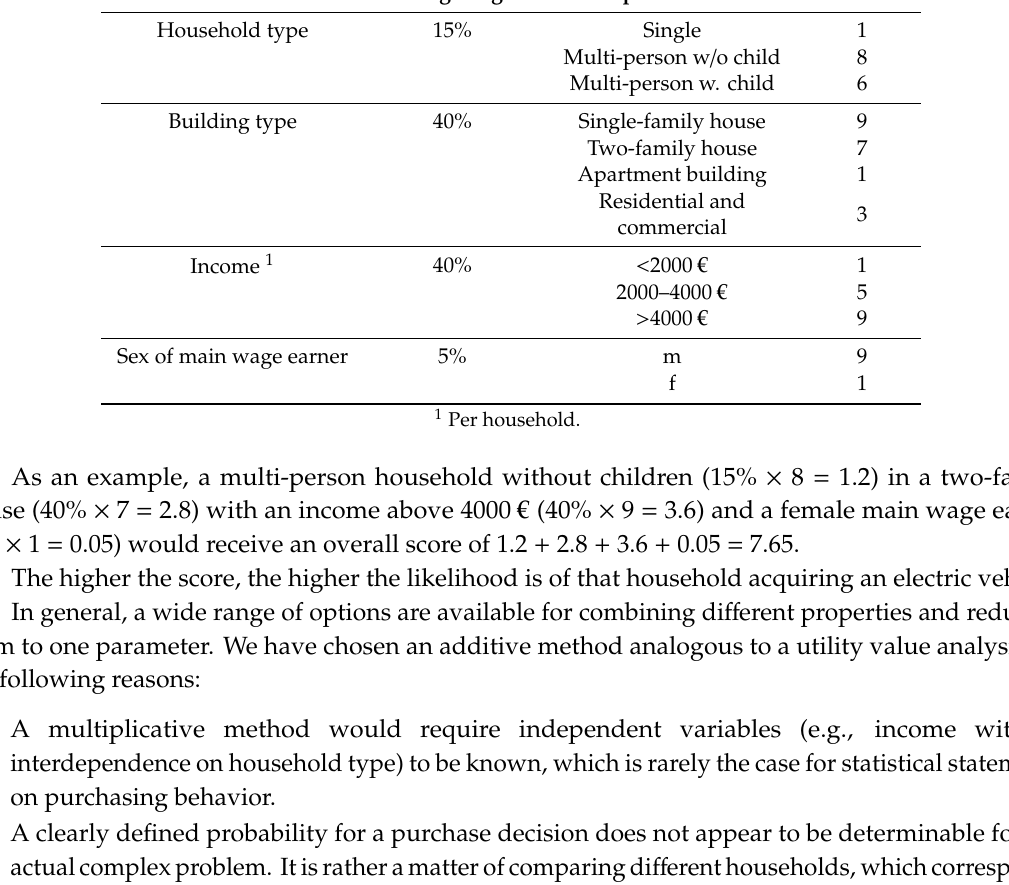
Table 1. Charging points at municipal level: Wiesbaden in 2040 as an application example. Attribute Weighting Specification Score Household